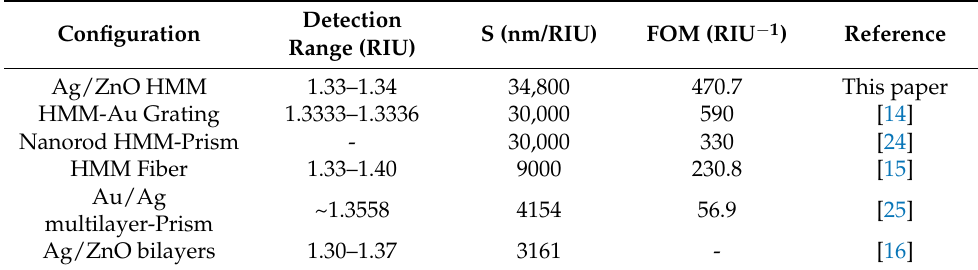
Table 1. Comparison of various SPR sensors.